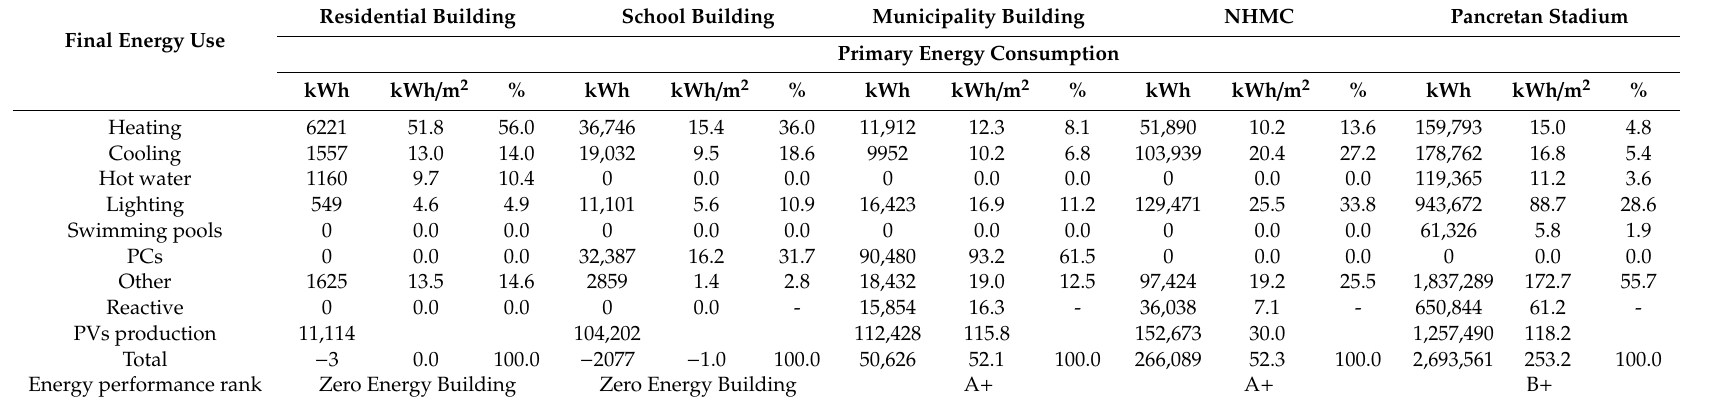
Table 8. Primary energy consumptions in the examined buildings after their energy performance upgrade.